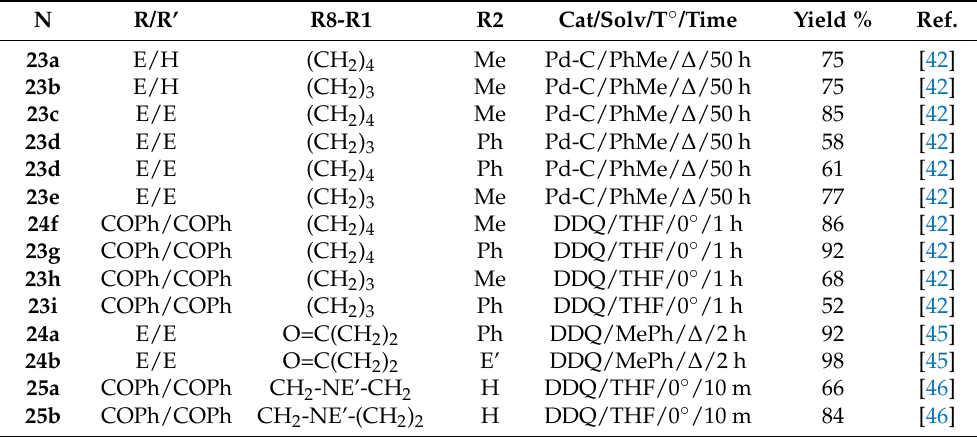
Table 2. Substituents and yields of cycloaddition of acetylenes to indolizines 23 – 25 annelated by a ring across the positions C1 and C-8 (Scheme 8).